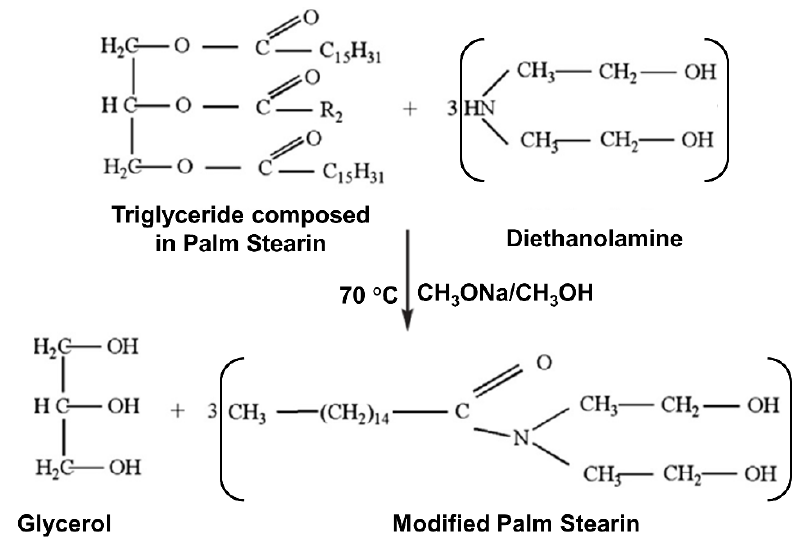
Figure 1. The chemical reaction between triglyceride-based palm stearin and diethanolamine (modified from Surya et al. [14]).